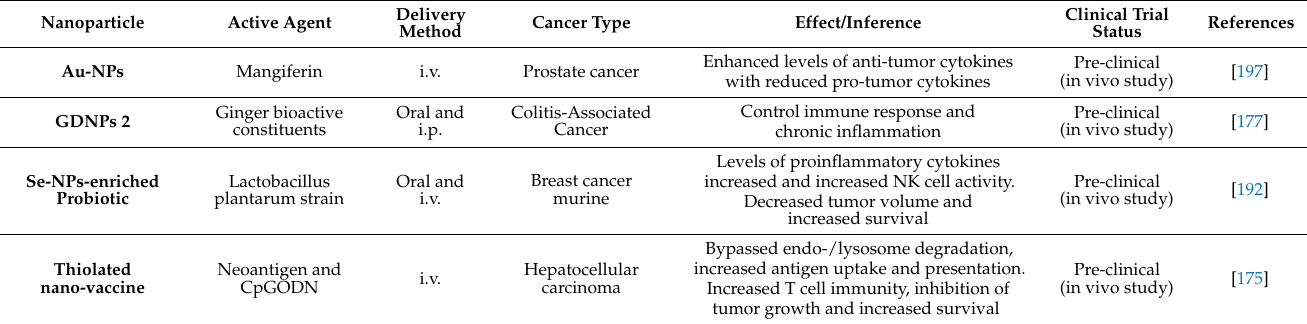
Table 4. Advanced of Nanotechnology in Cancer Vaccines for Immunotherapy and